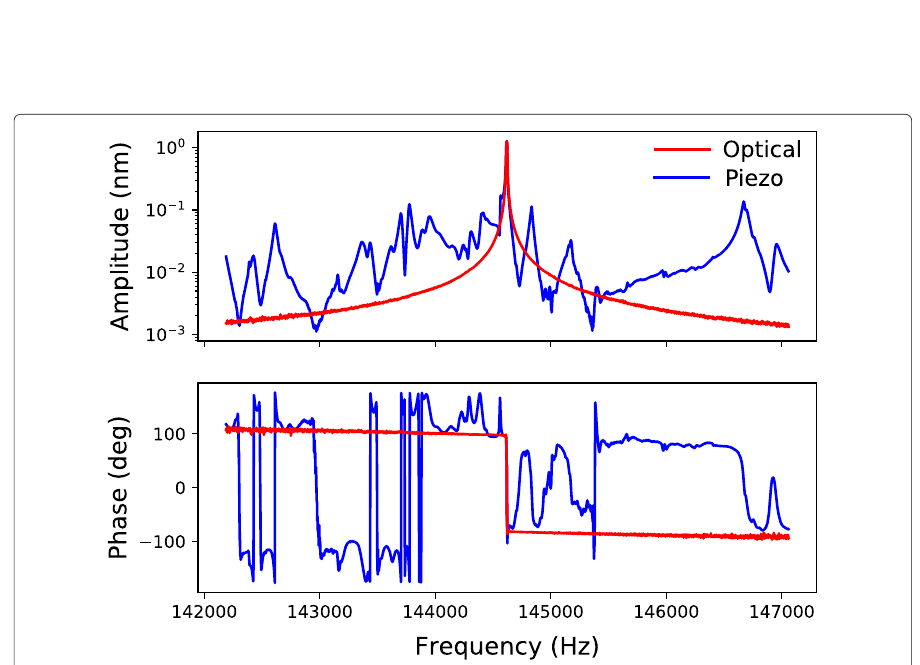
Fig. 4 Amplitude and phase frequency responses of the AFM cantilever excited by optical excitation (red) and piezo excitation (blue) measured at 4.5 K. Note the spurious mechanical resonances in the piezo excitation which arise from vibrations in the microscope